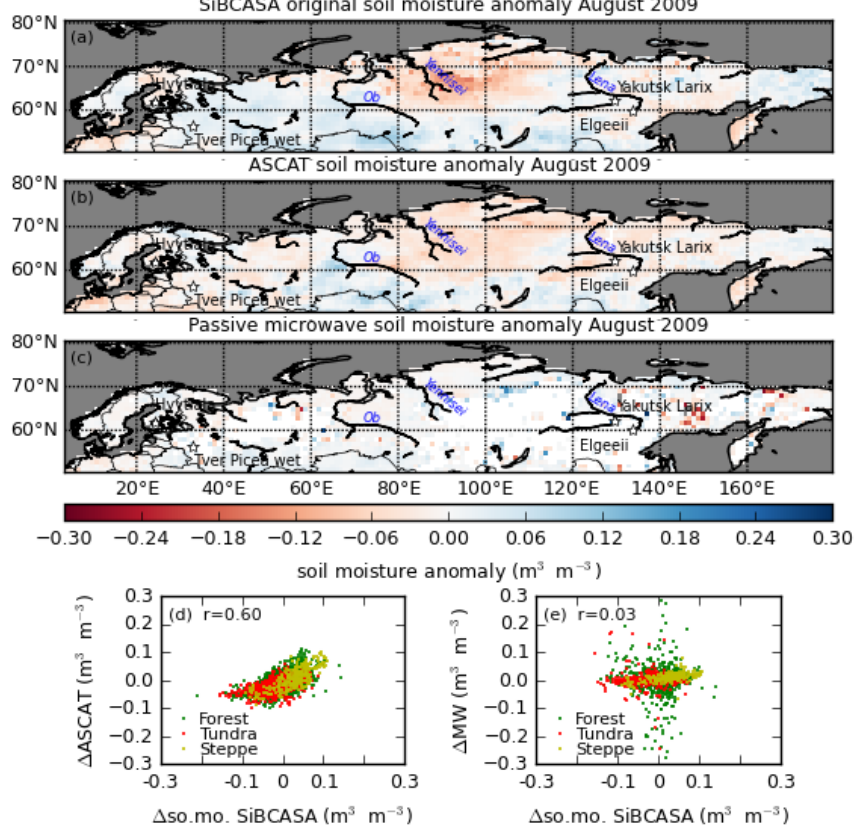
Figure 2. Soil moisture anomalies in August 2009 with respect to the average soil moisture in the months August 2007–2011. (a) – (c) The anomaly in SiBCASA, ASCAT and passive microwave soil moisture. (d) The spatial correlation between the anomalies in ASCAT and SiBCASA soil moisture; each point represents one grid point in the maps (a) and (b) . (e) The spatial correlation between passive microwave and SiBCASA soil moisture. The location of the four field sites is shown with open